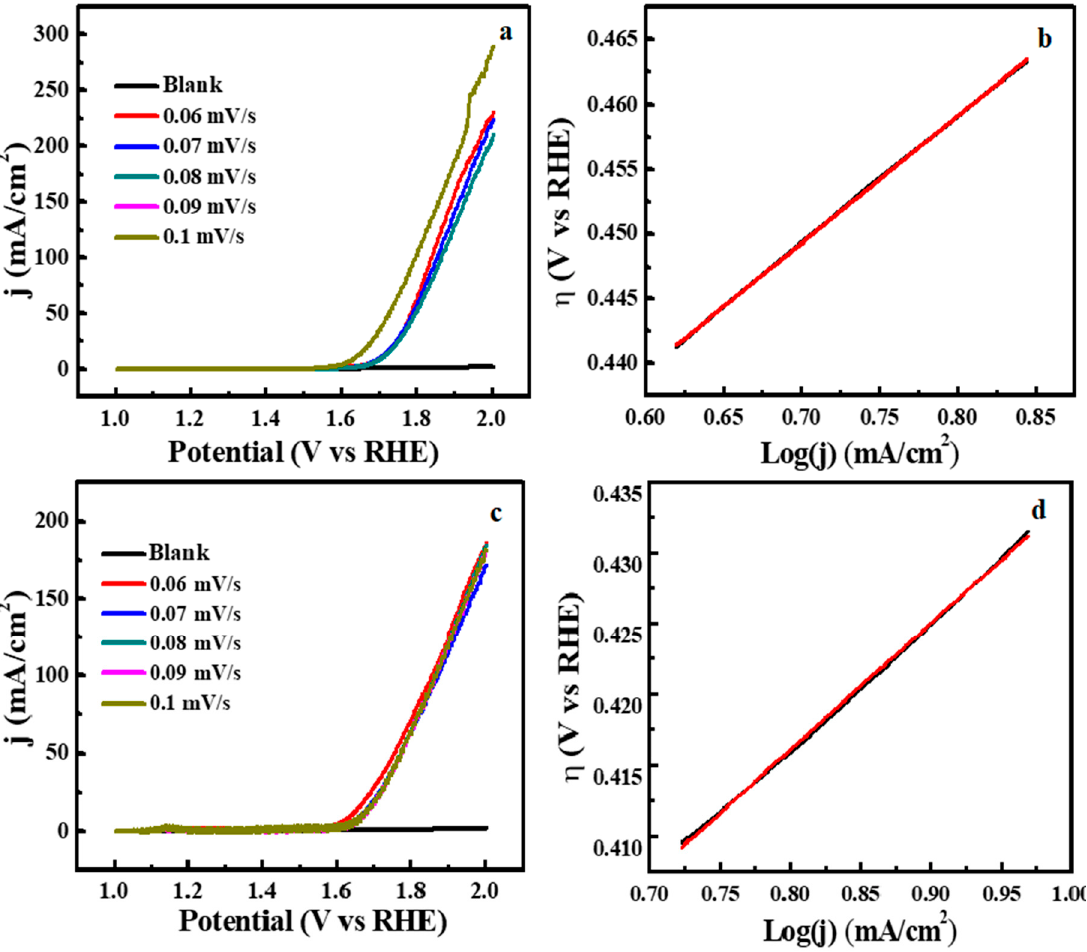
Figure 7. LSV curves of Cu 2 O-Co 3 O 4 /CN composite synthesized at ( a ) 400 °C and ( c ) 500 °C and corresponding Tafel slops ( b , d ) at different scan rates, in 1 M KOH.